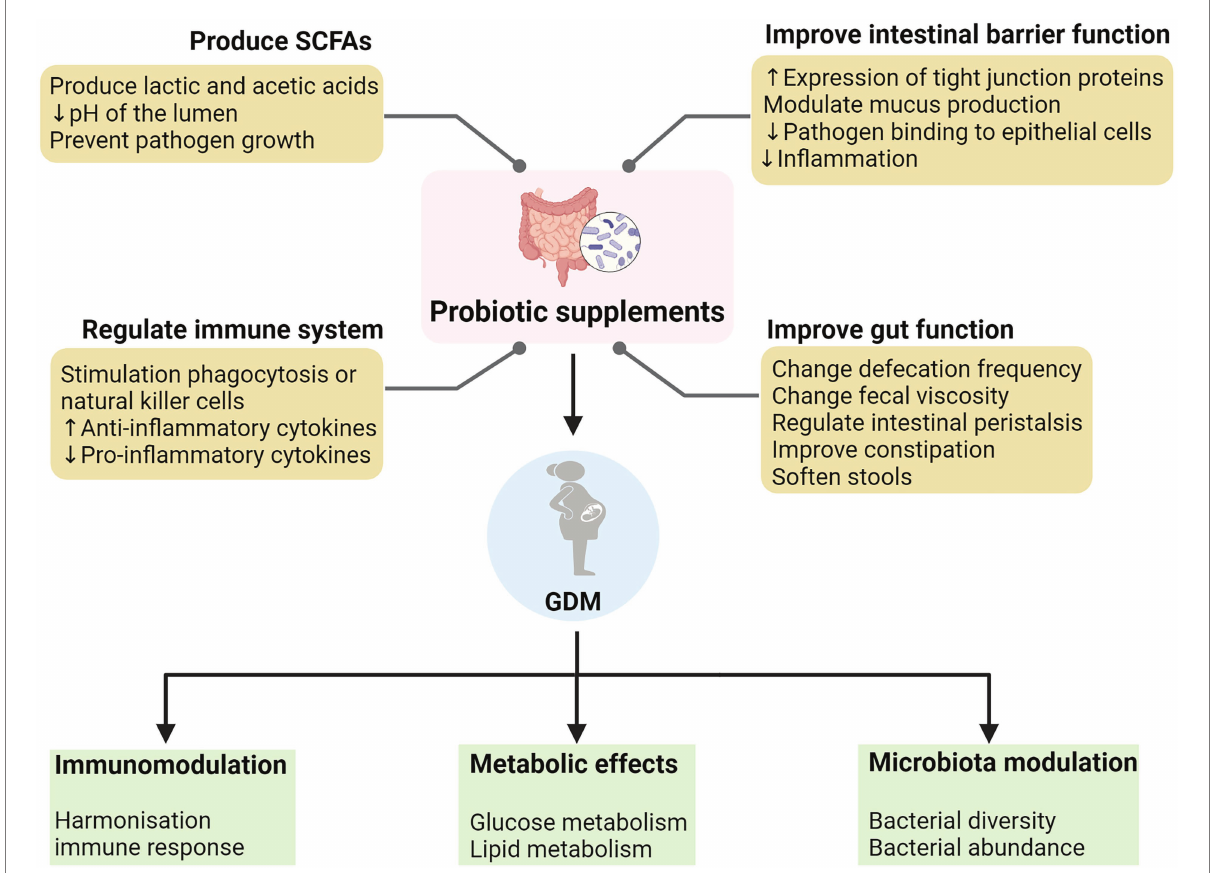
FIGURE 2 The mechanisms of action of probiotic supplements and its role in alleviating the pathology of gestational diabetes mellitus